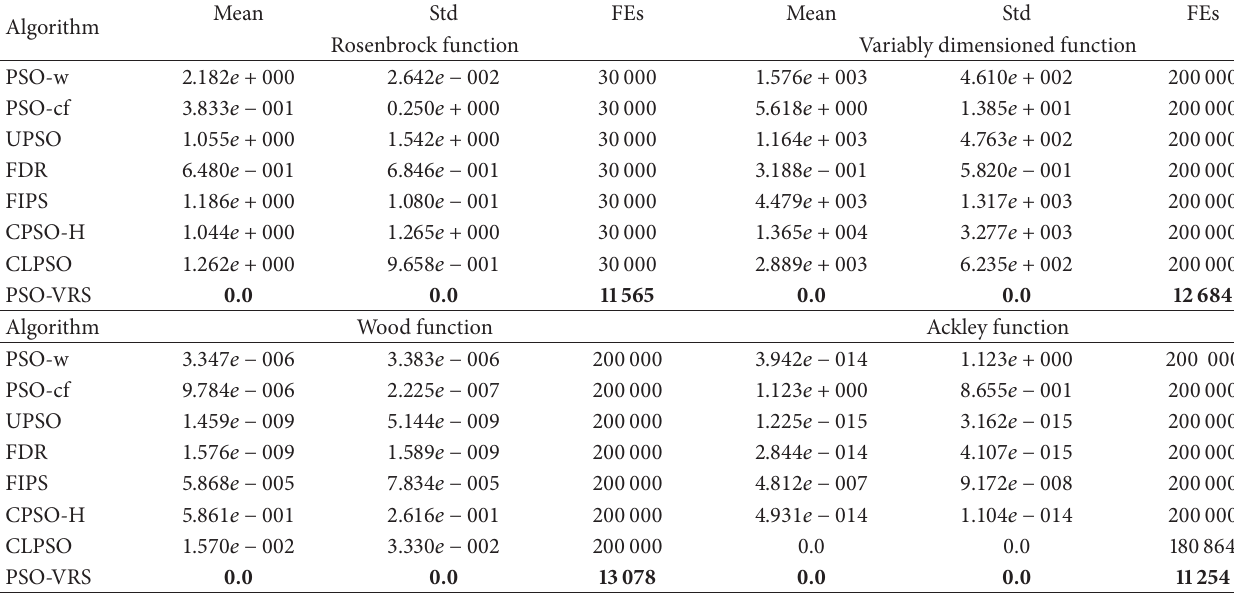
Table 1: Optimization results obtained for the test functions; the best results are shown in boldface.